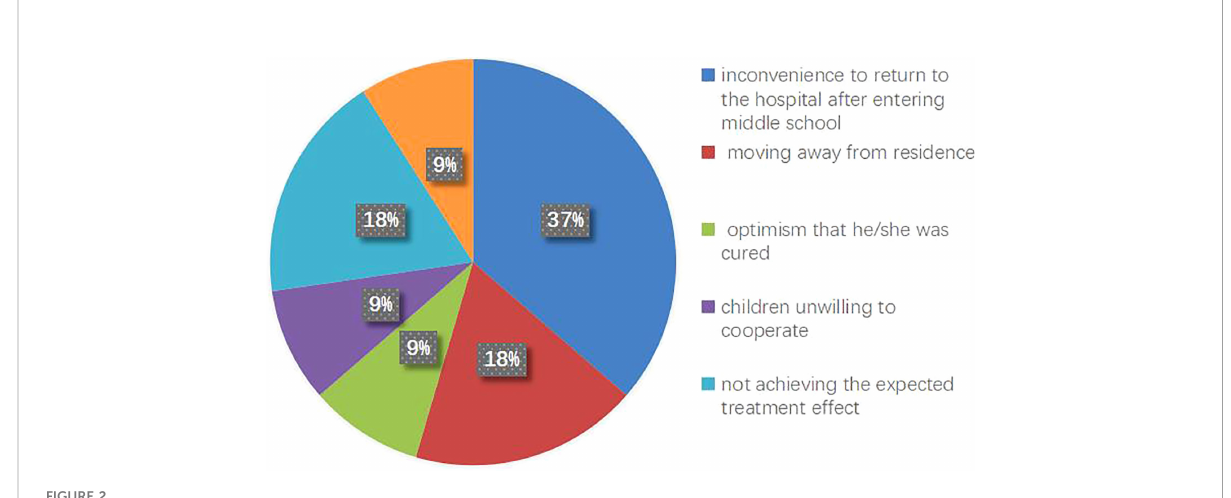
FIGURE 2 Reasons for patient drop-out in the CIT